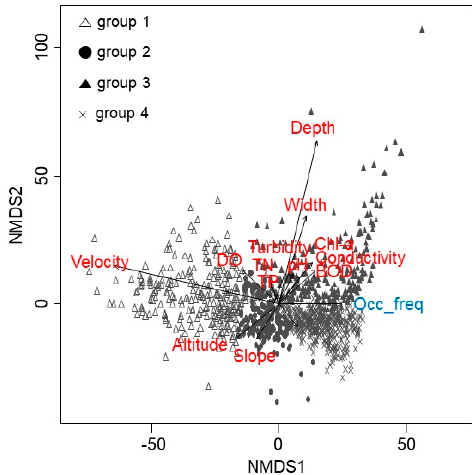
Figure 4. Nonmetric multidimensional scaling (NMDS) ordination of sampling sites based on the similarities of 13 environmental factors. The stress in the first two axes was 0.034. Occ_freq: occurrence frequency of Limnodrilus hoffmeisteri .